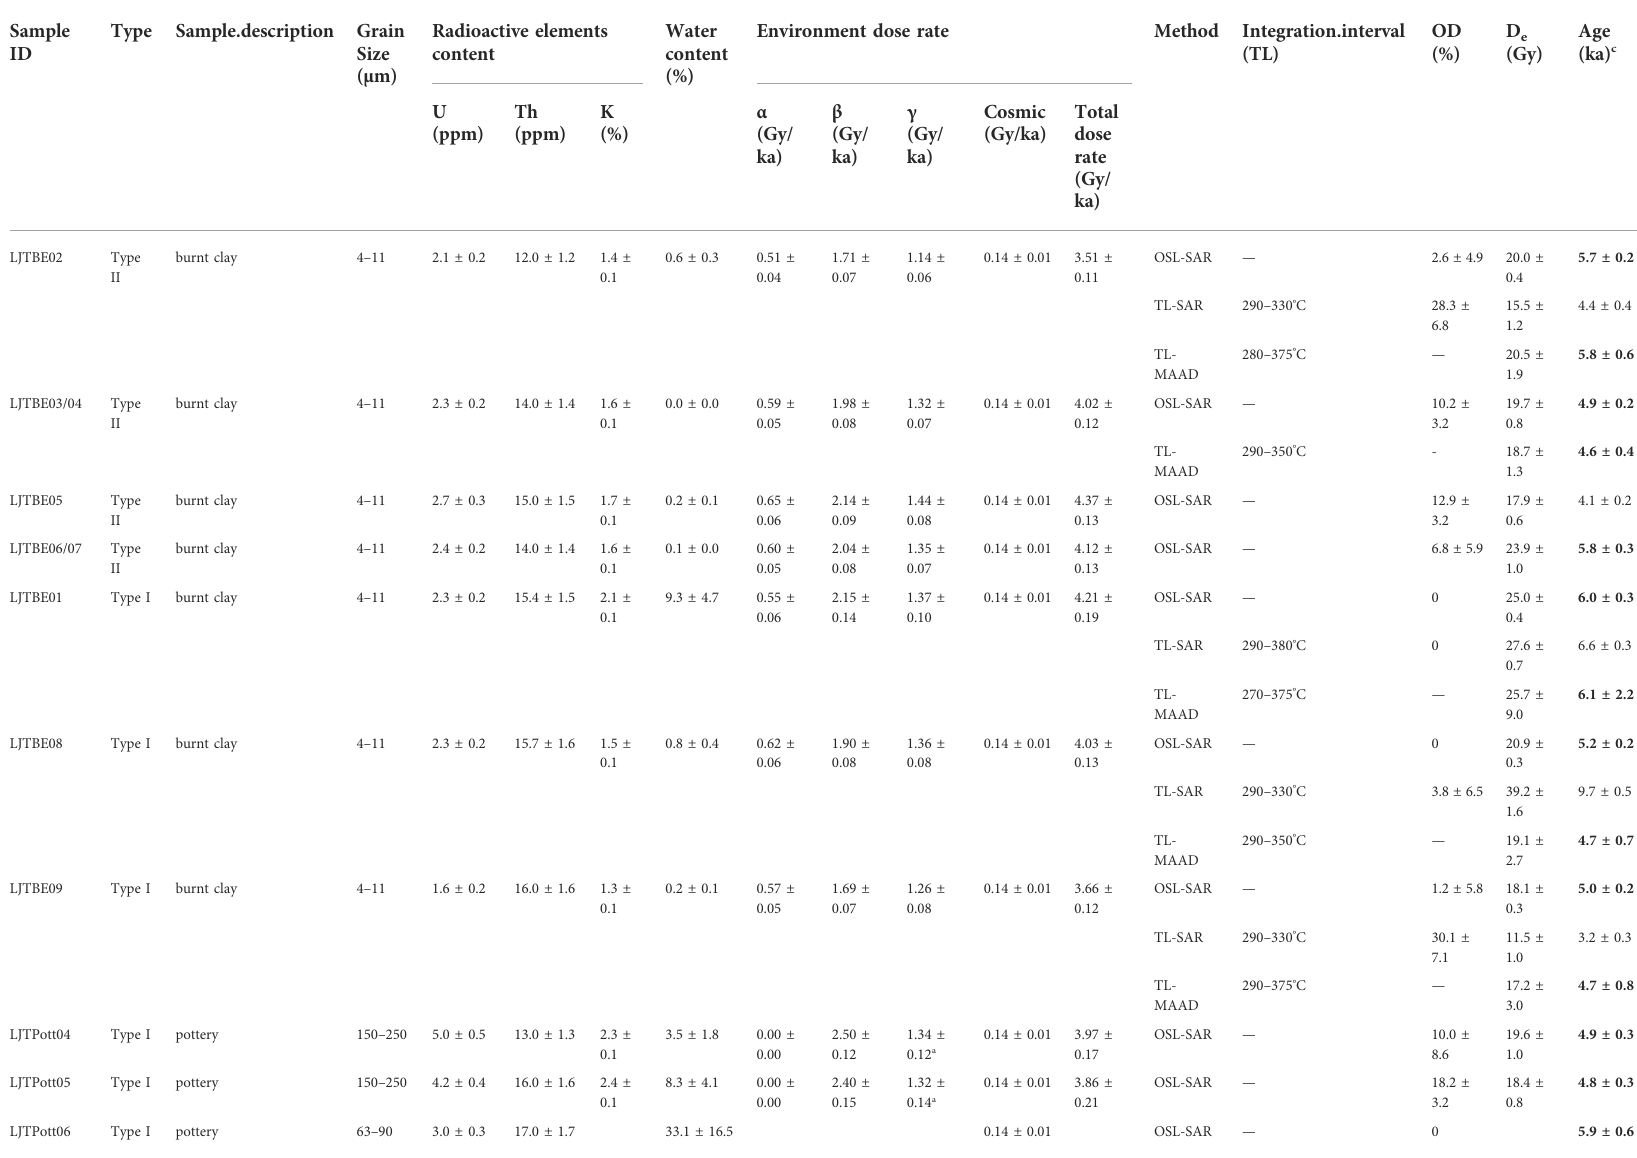
TABLE 1 Summary of sample description, radioactive element content, dose rate, OSL, TL and 14 C ages. Sample